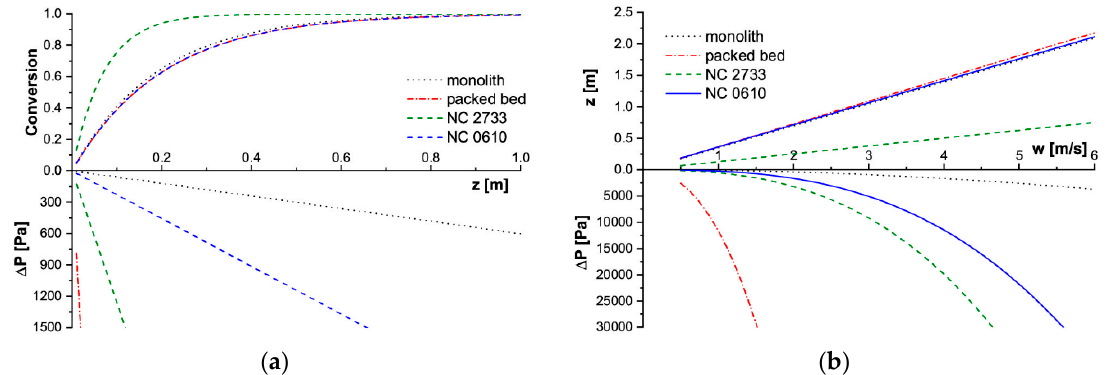
Figure 5. Modelling results for SCR deNOx process in T = 723 K. ( a ) Conversion and pressure drop profiles along the reactor length for w = 2 m/s, ( b ) Reactor length and corresponding pressure drop for assumed conversion X = 90%. SCR deNOx: selective catalytic reduction of nitrogen oxides.